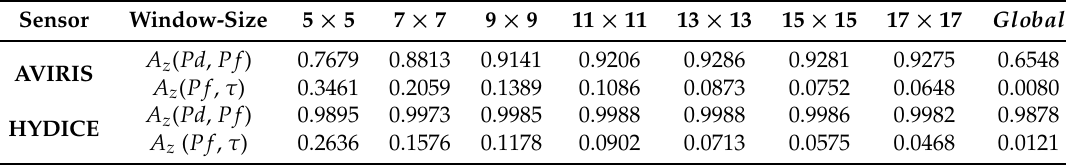
Table 4. Area under the ROC curve (AUC) values of ( Pd , Pf ) and ( Pf , τ ) with different window sizes Sensor